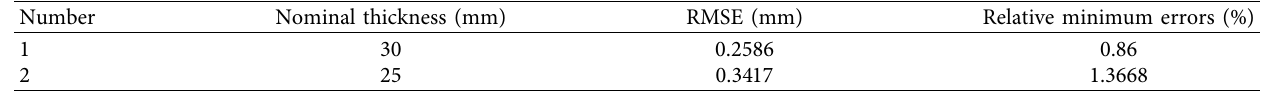
Figure 15: RMSE distribution maps of transparent objects of different thicknesses. Table 2: Measurement error analysis of transparent